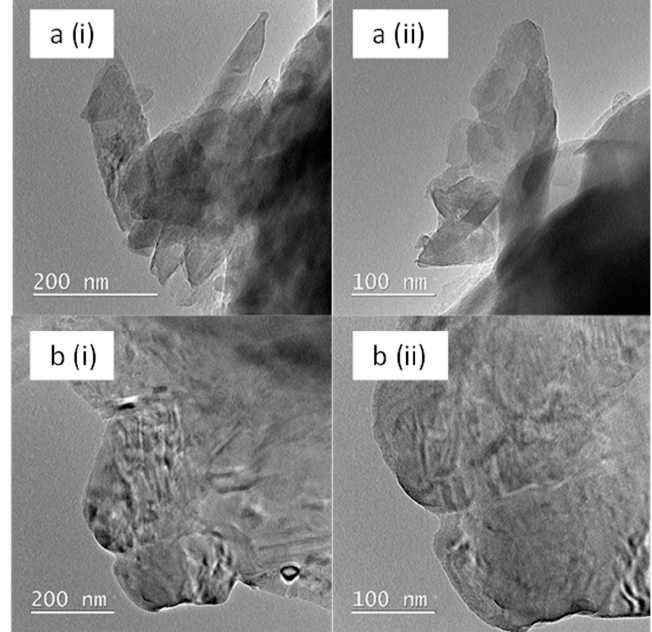
Figure 6. The transmittance electron microscopy (TEM) microtopography of the ( a ) natural zeolite powder and ( b ) HFCM derived from the 36 µ m natural zeolite, at di ff erent magnifications of (i) × 60 powder and ( b ) HFCM derived from the 36 μ m natural zeolite, at different magnifications of (i) ×60 and (ii) ×500. and (ii) ×